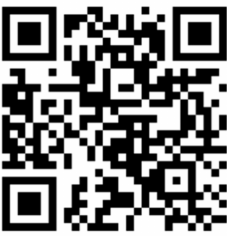
Figure 2. QR Code—All commands of Stata that were used in this